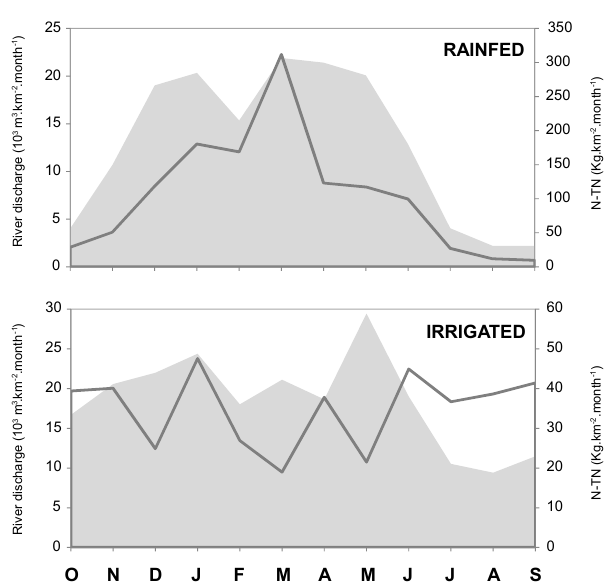
Fig. 9. Annual flow regime and N export in a rainfed and an irrigated catchment. Shaded areas represent river discharge and lines illustrate N